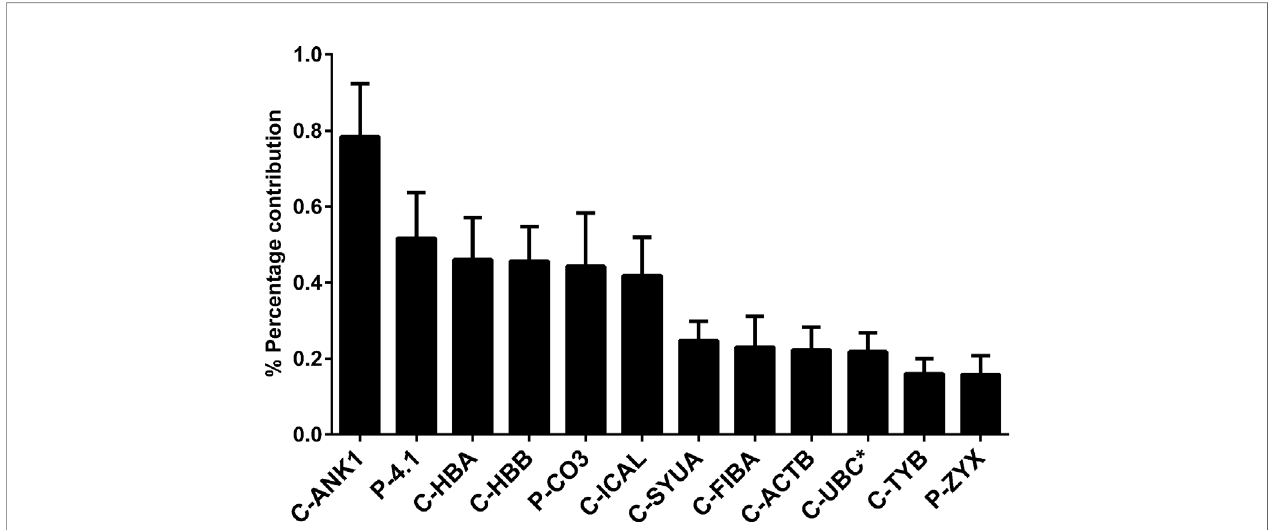
FIGURE 2 | Percentage of the contribution of proteins to the mass spectrum of Transferon. The relevance of proteins that consistently provide peptides to Transferon was determined based on their the average total mass spectrum obtained in the 10-batch sequencing analysis. The cluster ANK-1 contributes the most to the mass spectra of Transferon. The bars indicate standard deviation (SD) of the analysis. *, monomer. Clusters: ankyrin (ANK-1), hemoglobin subunit a (HBA), hemoglobin subunit b (HBB), calpastatin (ICAL), a -synuclein (SYUA), fi brinogen a -chain (FIBA), cytoplasmic actin 1 (ACTB), polyubiquitin C (UBC), thymosin (TYB); Proteins: protein 4.1 (4.1), complement C3 protein (CO3), and zyxin